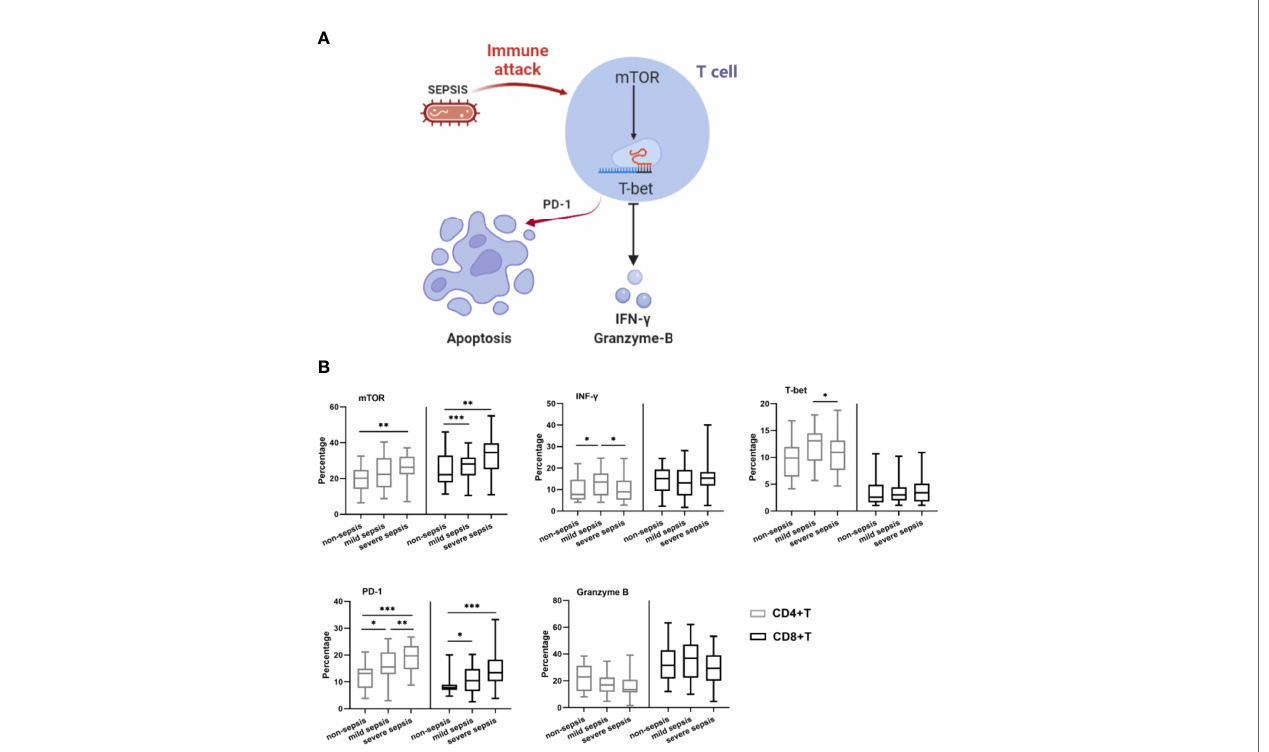
FIGURE 1 | Characterization of immune cell subsets. (A) Schematic of mTOR-mediated T cell apoptosis caused by immune attack in sepsis. (B) The lymphocyte count and immune cell subset of the study population. Expression of IFN- g , PD-1, T-bet, mTOR and Granzyme B on CD4 + T cells and CD8 + T cells in control group, mild and severe group were measured on day 1 at the onset of sepsis. Data are shown as box plot with max and minimum. *p<0.05; **p<0.01; ***p<0.001